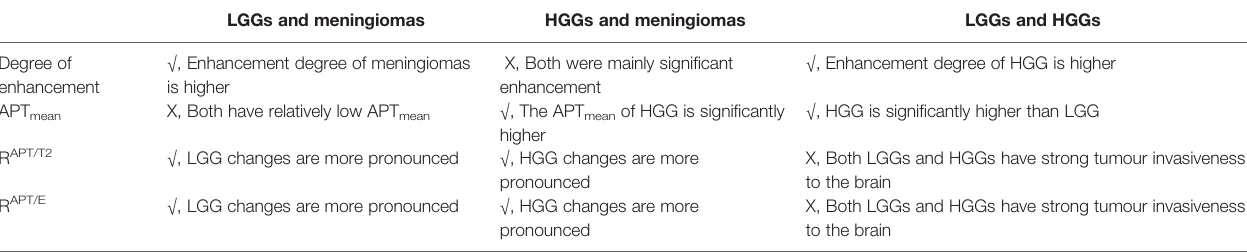
TABLE 2 | APT and enhancement features to differentiate LGGs, HGGs, and meningiomas. LGGs and meningiomas HGGs and meningiomas LGGs and HGGs